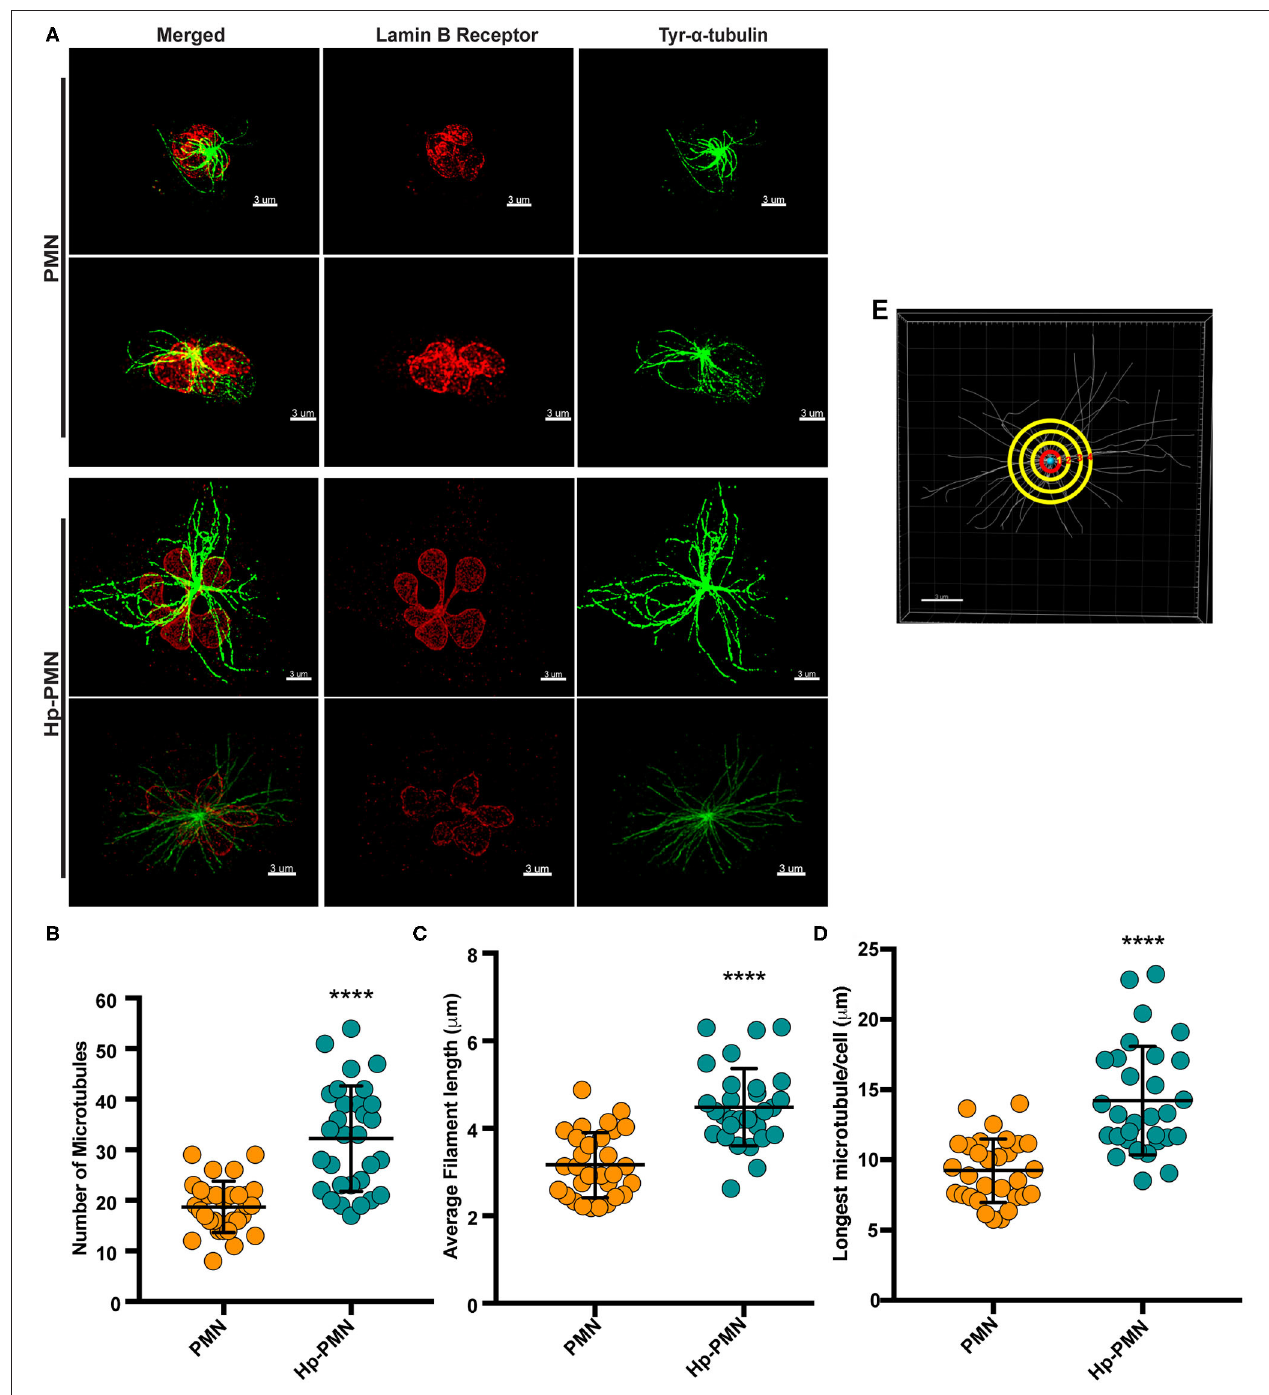
FIGURE 3 | MTs are more abundant and longer in infected PMNs. Infected and control PMNs were processed for analysis by STED at 24h. (A) Representative 3D reconstructions of STED Z-stack images. Lamin B receptor (LBR) was detected using TRITC-conjugated secondary antibodies (red) and tyrosinated α -tubulin was detected using FITC-conjugated secondary antibodies (green). Scale bar = 3 µ m (x1,000 original magnification). (B–E) MT length and abundance were quantified for 10 cells per donor and condition in each experiment. Graphs show the number of MTs radiating from the MTOC (B) , average filament length (C) , and longest MT in each cell (D) . Data for individual cells (symbols) are shown along with the mean and standard deviation ( n = 3). A Welsh t -test was done to determine significance. **** P ≤ 0.0001. (E) Representation of MT analysis. The red circle denotes 1 µ m from the MTOC. Tubules that intersect this circle were counted (B) . MTs in each image were traced using the Autodepth Filament feature of Imaris (C,D)